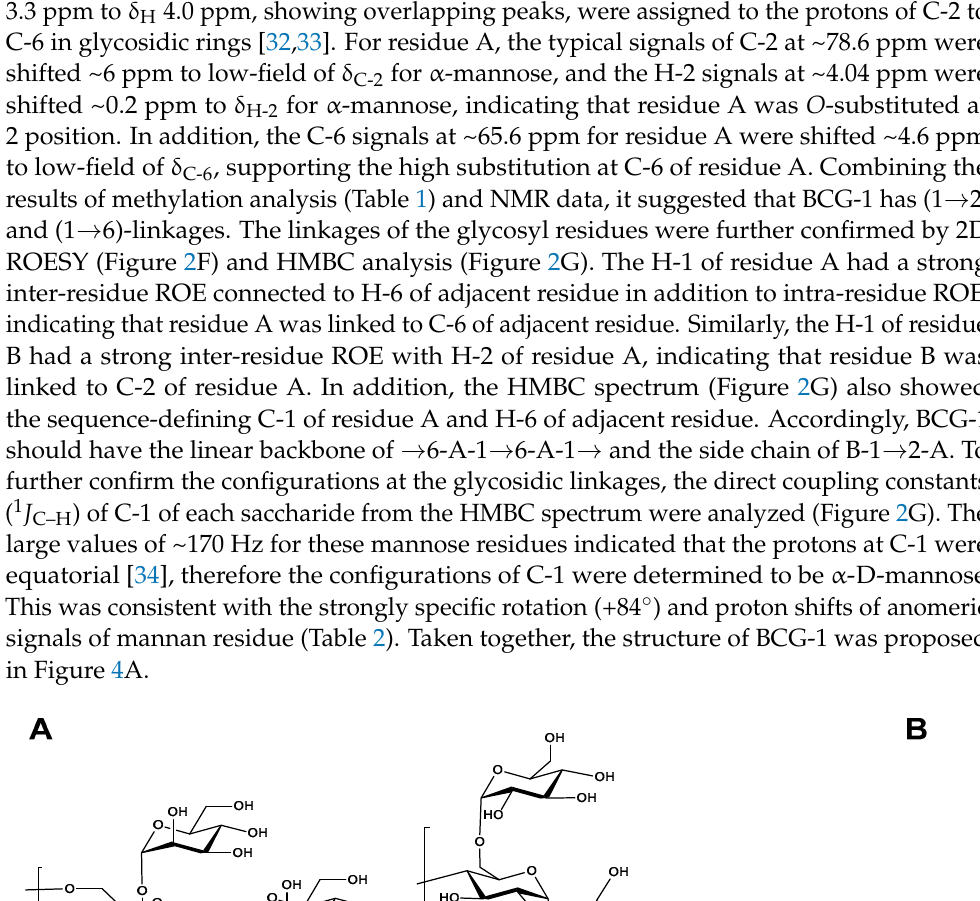
Figure 5. Effects of LPS, BCG-PSN, BCG-1, and BCG-2 on the production of NO ( A ) and mRNA expressions of iNOS ( B ) in RAW264.7 cells. LPS was at 100 ng/mL, BCG-PSN was at 87.5 μ g/mL. * p < 0.05, ** p < 0.01, and *** p < 0.001 vs. control, one-way ANOVA, Dunnett’s multiple comparisons test. 3.7. Effects of BCG-1 and BCG-2 on the Production of Cytokines Activated macrophages can release inflammation cytokines, such as TNF- α , IL-6, IL- 1 β , and IL-10 [41]. In turn, the levels of these cytokines can be used to evaluate the activa- tion degree of macrophage. At the tested concentration, BCG-1, BCG-2, and BCG-PSN in- jection could potently promote the release of TNF- α from RAW264.7 cells (Figure 6A), BCG-1 and BCG-2 at 1 μ g/mL increased TNF- α to more than four folds of the control, comparable to the effect of LPS (100 ng/mL), and the production of TNF- α seemed to plat- eau without further increase with higher doses. BCG-1, BCG-2, and BCG-PSN injection